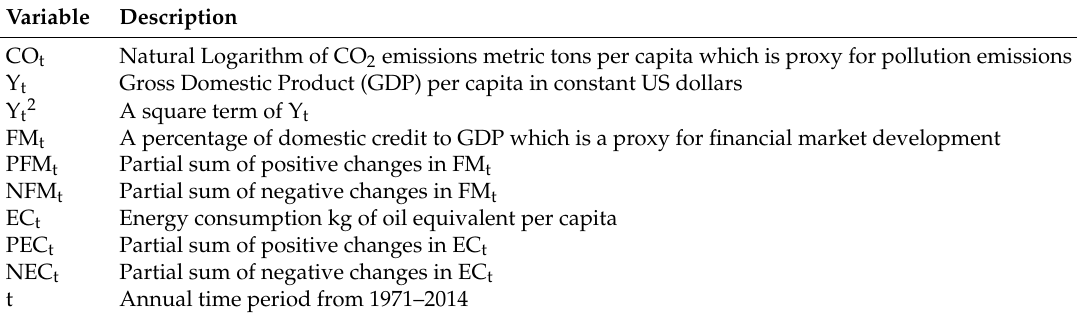
Table 1. Description of